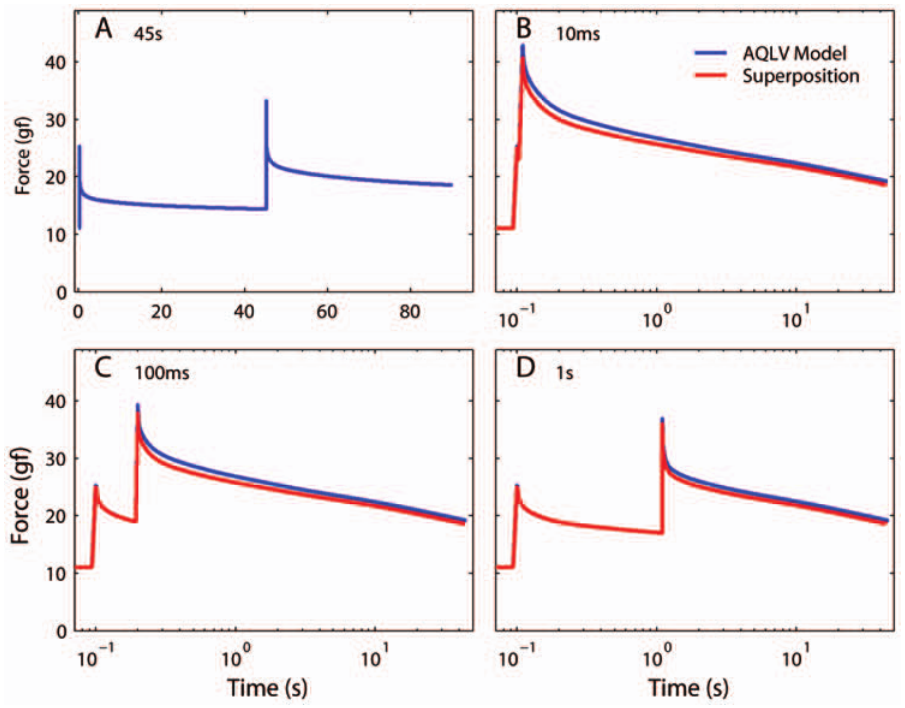
Figure 10. The AQLV model does not obey superposition. Same as Fig. 9, but now the AQLV model is used for the simulations. In all cases the model output is larger than the superposition prediction. The deviation between the two traces is maximal at the end of the second step, and is larger for shorter inter-step intervals. Some of the deviation toward the end of each simulation can be imputed to the incomplete settling of the model output just before the second step in panel A, but the initial deviation is due to the lack of superposition in this